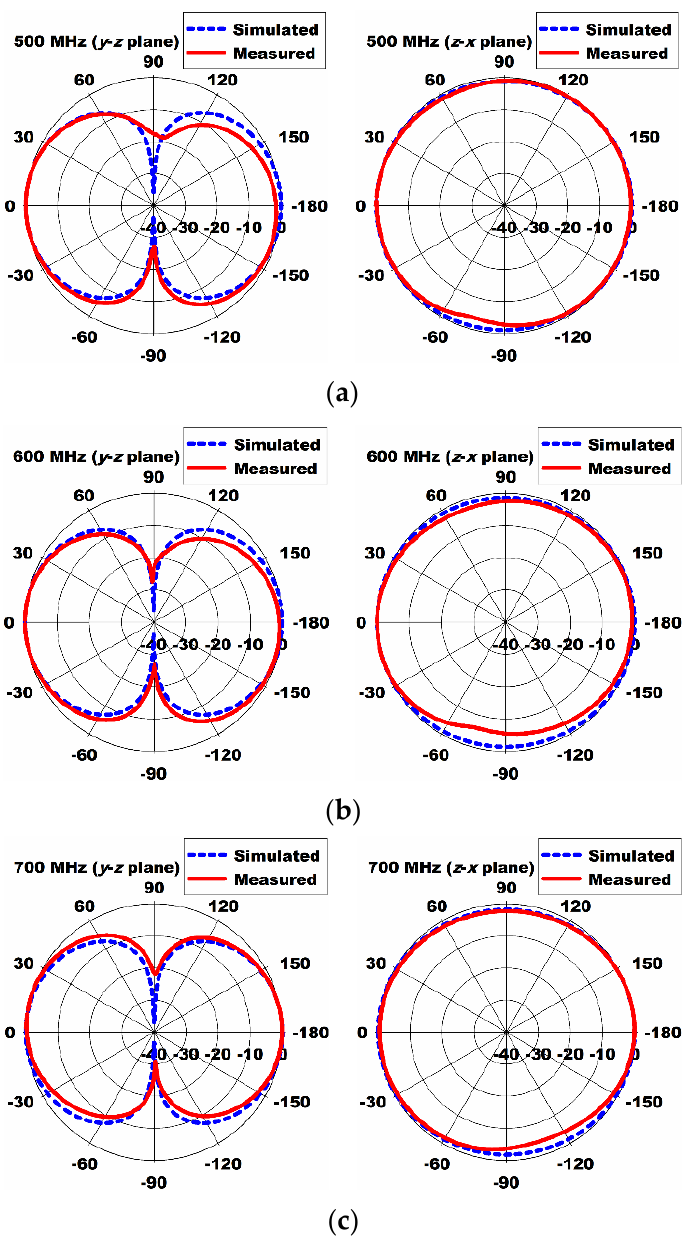
Figure 13. Measured radiation patterns of the fabricated antenna in the y – z and z – x planes at ( a ) 500 MHz; ( b ) 600 MHz; ( c ) 700 MHz.